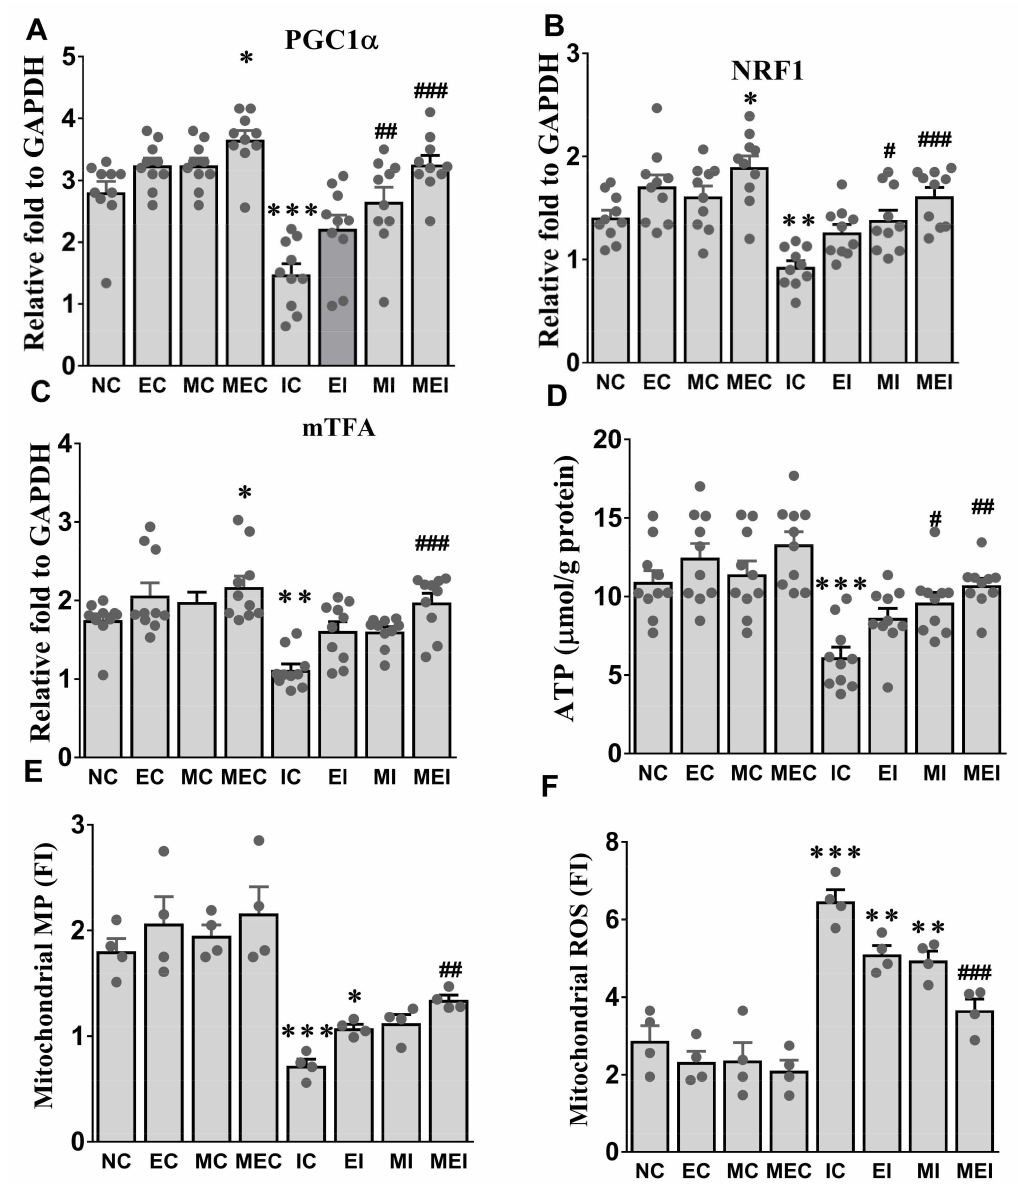
Figure 3. Effect of melatonin and exercise on cardiac mitochondrial function in isoproterenol- challenged rats. ( A ) PGC-1 α , Peroxisome proliferator-activated receptor gamma coactivator 1 α ; ( B ) NRF-1, Nuclear respiratory factor-1; ( C ) mTFA, Mitochondrial transcription factor-A; ( D ) ATP, adenosine triphosphate; ( E ) Mitochondrial MP, membrane potentials; ( F ) Mitochondrial ROS, reactive oxygen species. The data are reported as the mean ± SEM ( n = 4). * p < 0.05, ** p < 0.01, and *** p < 0.001 versus the NC group. # p < 0.05, ## p < 0.01, and ### p < 0.001 versus the IC group calculated through the Bonferroni post hoc test following one-way ANOVA. ROS, reactive oxygen species; FI, fluorescence intensity; NC, normal control; EC, exercise control group; MC, melatonin control group; MEC, melatonin plus exercise control group; IC, isoproterenol control group; EI, exercise plus isoproterenol-challenged group; MI, melatonin plus isoproterenol-challenged group; MEI, melatonin and exercise plus isoproterenol-challenged group; MMP, mitochondrial membrane potential; ROS, reactive oxygen species; FI, fluorescence